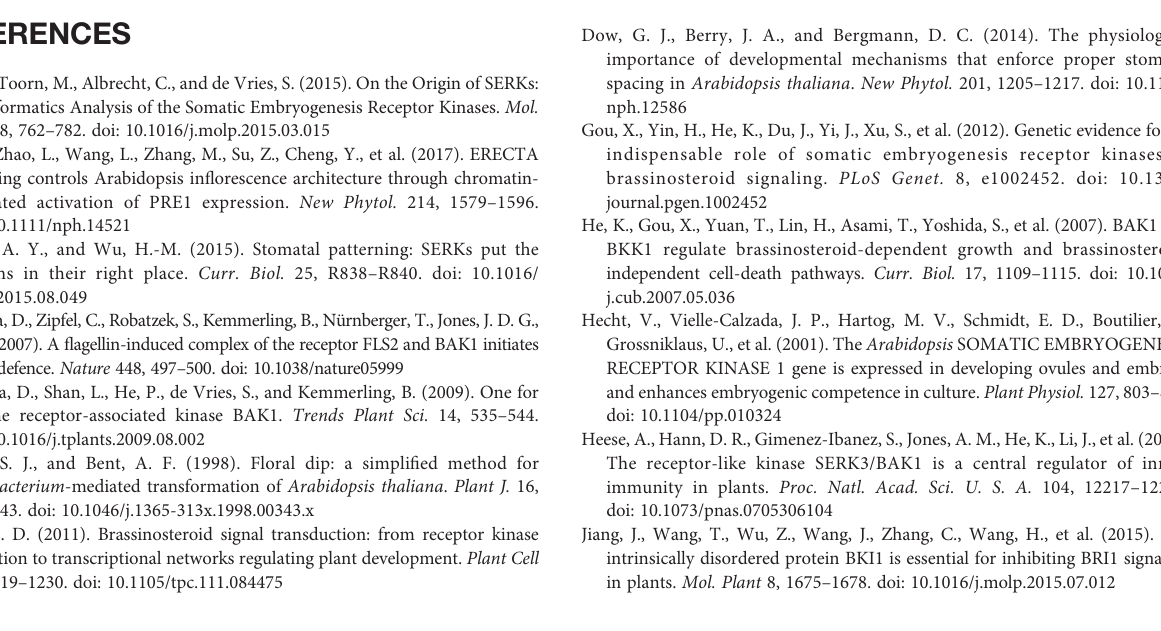
SUPPLEMENTARY FIGURE 1 | Alignment of the amino acid sequences. ZmRLK7 was aligned with its four maize homologs, Arabidopsis RGI3 (AT4G26540.1) and rice LOC_Os09g30190.1 using BioEdit software with default options. The 10 leucine-rich repeat (LRR), transmembrane and protein kinase domain are underlined. Amino acid positions are shown on the top, and identical and conserved residues are marked as asterisks and dots/colons, respectively. SUPPLEMENTARY FIGURE 2 | PCR veri fi cation of the transgenic lines and bak1-3 . (A) Veri fi cation of ZmRLK7 sense transgenic lines. (B) Veri fi cation of ZmRLK7 antisense transgenic lines. (C) T-DNA insertion sites of Arabidopsis bak1- 3 mutant with exons shown as black boxes. (D) PCR veri fi cation of bak1-3 mutant. M,DL2000marker; RS-3andRS-5,sense ZmRLK7 transgeniclines;RA-1andRA- 3, antisense ZmRLK7 transgenic lines; RS/ bak1-3 ① and ② are sense ZmRLK7 transgenic lines in the background of bak1-3 ; RA/ bak1-3 ① and ② are antisense ZmRLK7 transgenic lines in the background of bak1-3 ; WT, wild type; P, plasmid control. SUPPLEMENTARY FIGURE 3 | Morphology at vegetative stage. (A) and fl oweringstage (B) .WT,wildtype;RS-3andRS-5,sense ZmRLK7 transgeniclines; RA-1 and RA-3, antisense ZmRLK7 transgenic lines. Bars = 2 cm for (A) and 5 cm for (B). SUPPLEMENTARY FIGURE 4 | Stomata phenotypes at leaf abaxial epidermis. (A – E) stomatal index (F) and qRT-PCR analysis for SPCH , MUTE and FAMA (G) WT, wild type; RS-3 and RS-5, sense ZmRLK7 transgenic lines; RA-1 and RA-3, antisense ZmRLK7 transgenic lines. AtUBQ10 gene was used as internal control. Values are means of three biological replicates with SD. * and ** denote signi fi cant differences at p < 0.05 and 0.01 by ANOVA, respectively. Bars = 100 m m. All comparisons were with the WT as the control. SUPPLEMENTARY FIGURE 5 | qRT-PCR analysis of RGI3 (A) and fl owering date of WT and bak1-3 (B) . WT, wild type; RS-3 and RS-5, sense ZmRLK7 transgenic lines; RA-1 and RA-3, antisense ZmRLK7 transgenic lines; RS/ bak1-3 , sense ZmRLK7 transgenic lines in the background of bak1-3 . Bar = 5